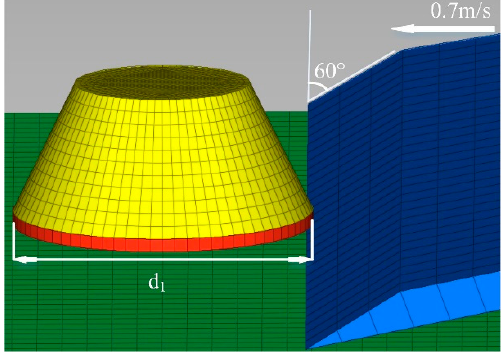
Figure 15. The simulation diagram of barnacle.